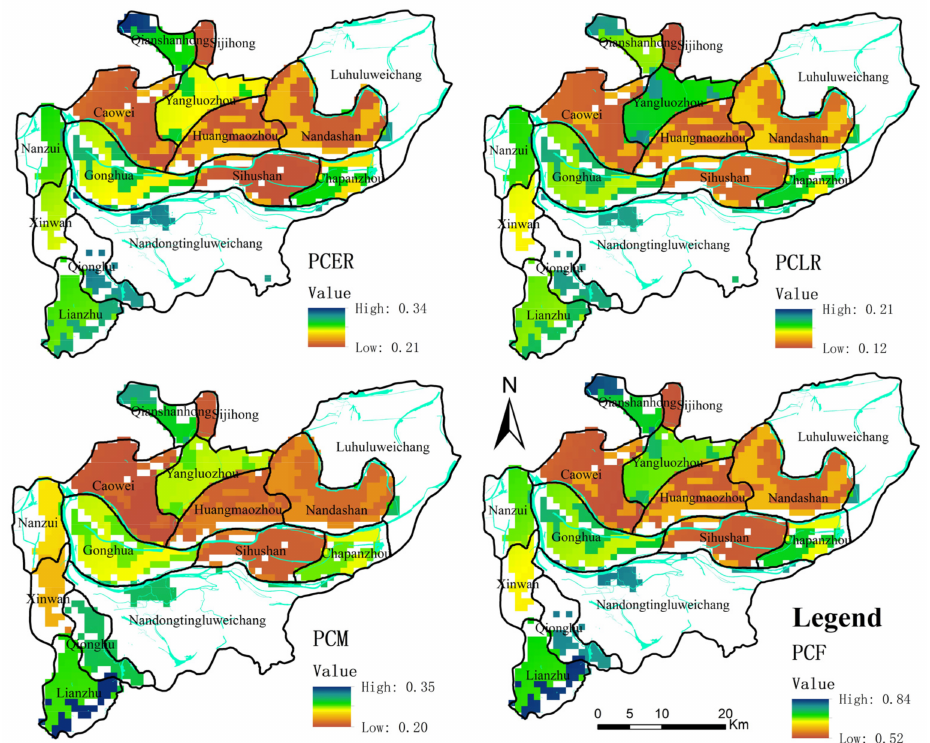
Figure 8. Production capacity of farmland in Yuanjiang county (unit: